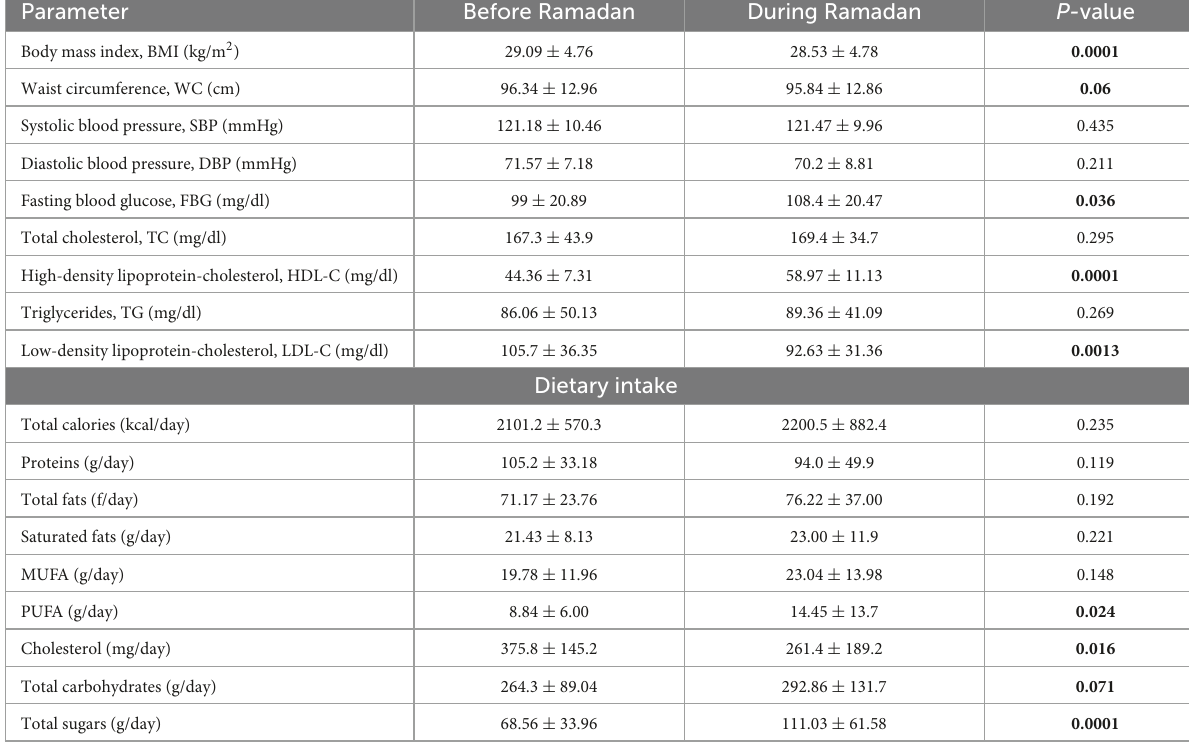
TABLE 2 Changes in anthropometric, biochemical and dietary intake variables before and during Ramadan fasting month. Parameter Before